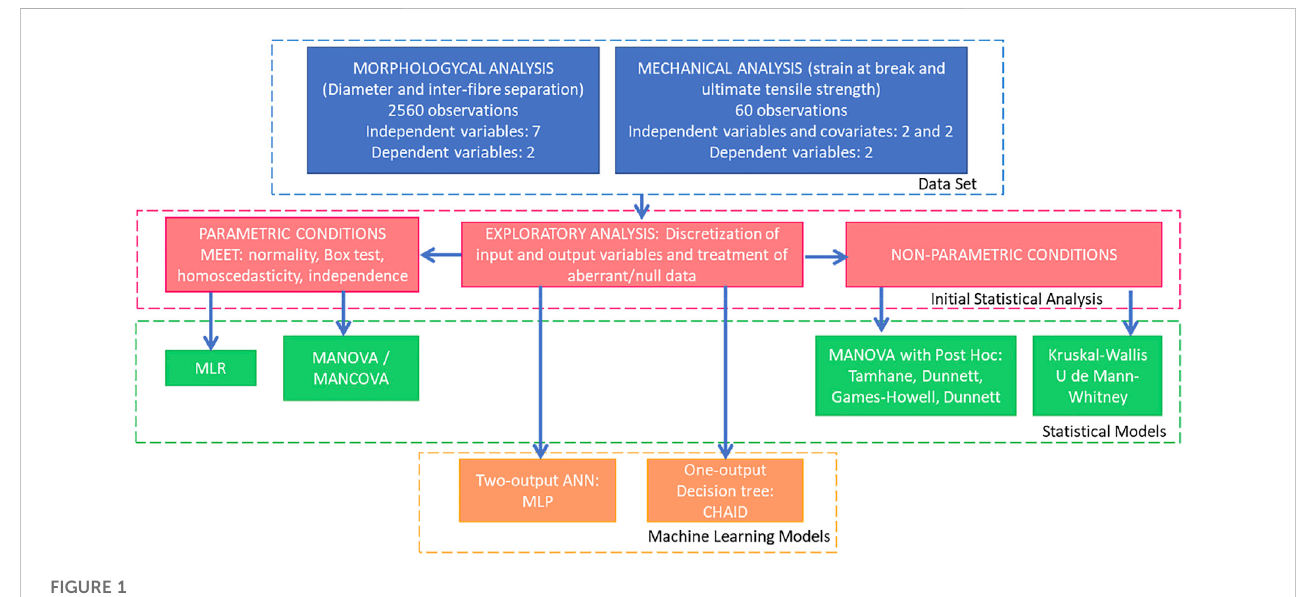
FIGURE 1 Outline of the followed